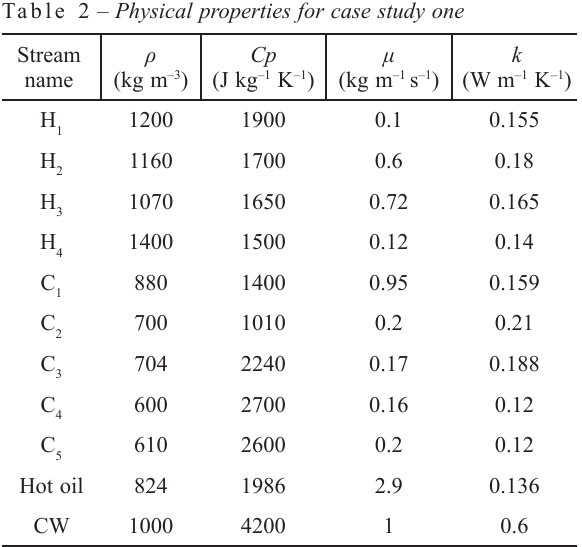
Fig. 6 – Optimal HEN for case study one with ΔT